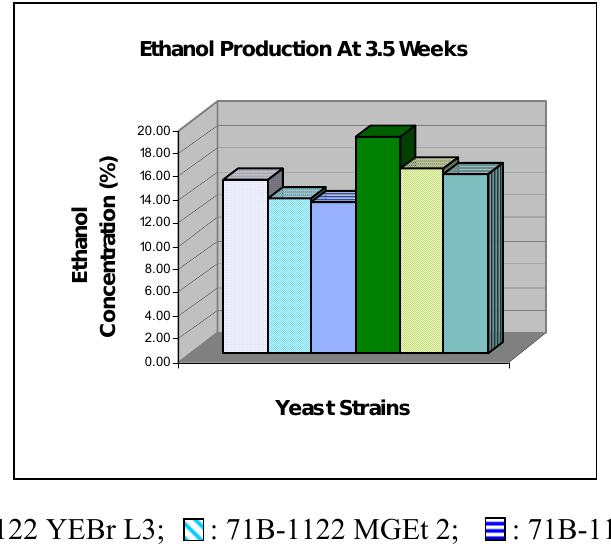
Figure 5. Comparison of Ethanol Yield from Mutant and Parental Strains at